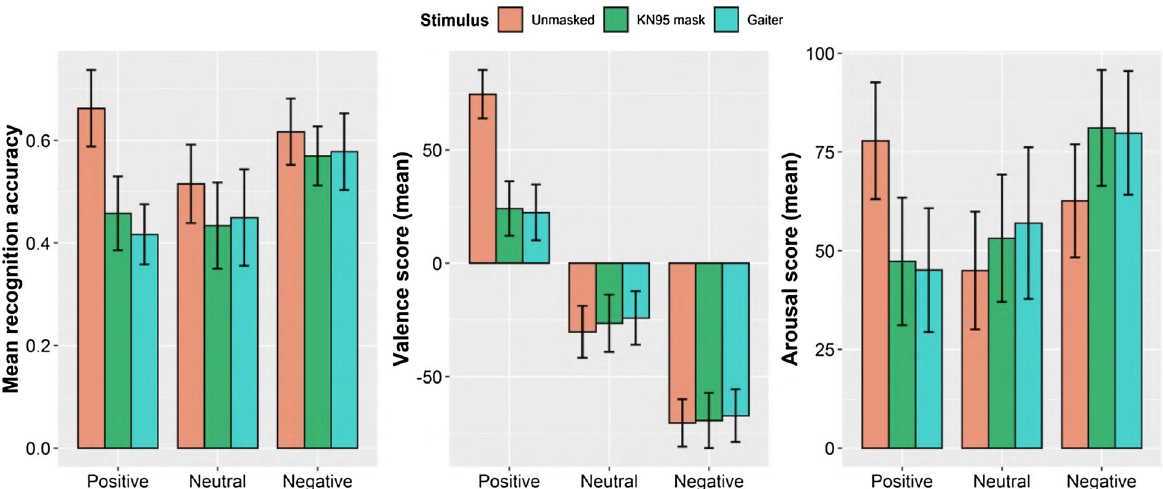
Figure 1. Results of Experiments 1 and 2. Left: Average recognition accuracy for positive, neutral, and negative mental states across the three conditions. (Note that the guess rate in a four-alternative forced choice paradigm is 25%.) Middle: Average perceived valence scores showing a significant decrease in valence between the unmasked and the two covering conditions for positive mental states (but not for the neutral and negative ones). Right: Average perceived arousal scores showing a significant decrease in perceived arousal for the positive expressions and a significant increase for neutral and negative ones. Error bars represent standard deviation of the